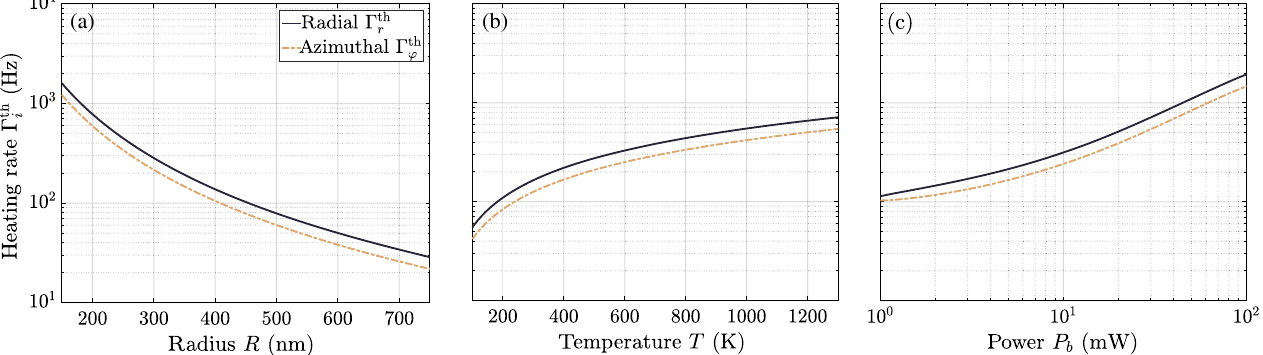
FIG. 1. Atom heating rate in the radial and azimuthal direction calculated using Eq. (15) as function of (a) the nanofiber radius, (b) the temperature of the nanofiber, and (c) the power of the blue-detuned trapping laser. The difference between Eq. (15) and the full theory Eq. (10) is not discernible at the given scales. In (a) and (b), all other parameters, in particular, the trap frequencies, are unchanged. In (c), the ratio between the power of the red- and blue-detuned laser is kept constant, P power and temperature is modeled as T ð P Þ ¼ m 0 þ m 1 P þ m 2 P 2 , with m 0 ¼ 400 K, m 1 ¼ 24 K = mW, m 2 ¼ − 0 . 062 K = mW 2 based on the measurements in Ref. [55] for a nanofiber of radius R ¼ 250 nm and length L ¼ 5 mm. The temperature then varies from T ¼ 427 to 2298 K over the shown range of laser power. The trap frequencies simultaneously increase from ð ω ð 29 . 1 ; 23 . 9 Þ kHz to 2 π × ð 291 ; 168 Þ kHz. The remaining parameters are specified in Appendix